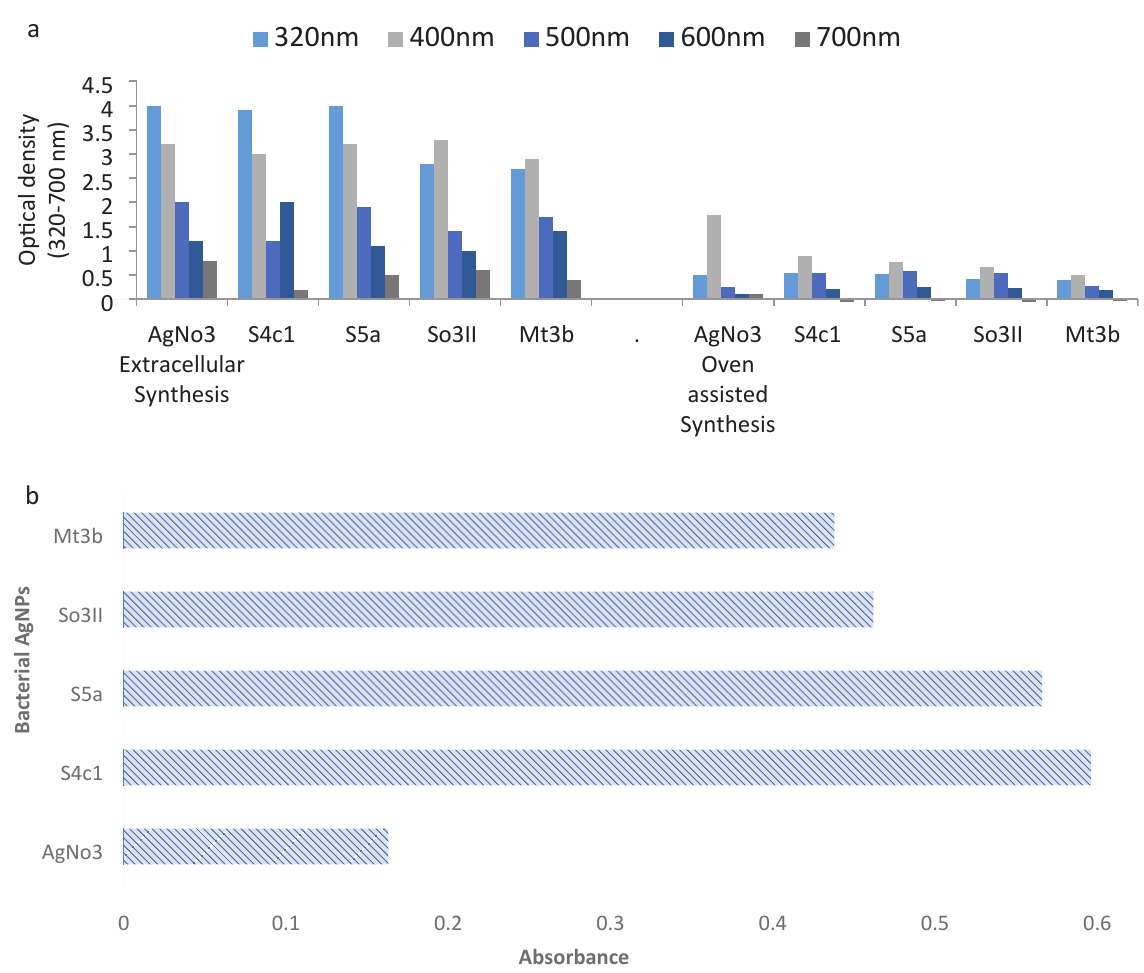
Figure 1: (a) Extra-cellular and oven assisted synthesis of bacterial AgNPs; (b) UV-Visible spectroscopic analysis of bacterial